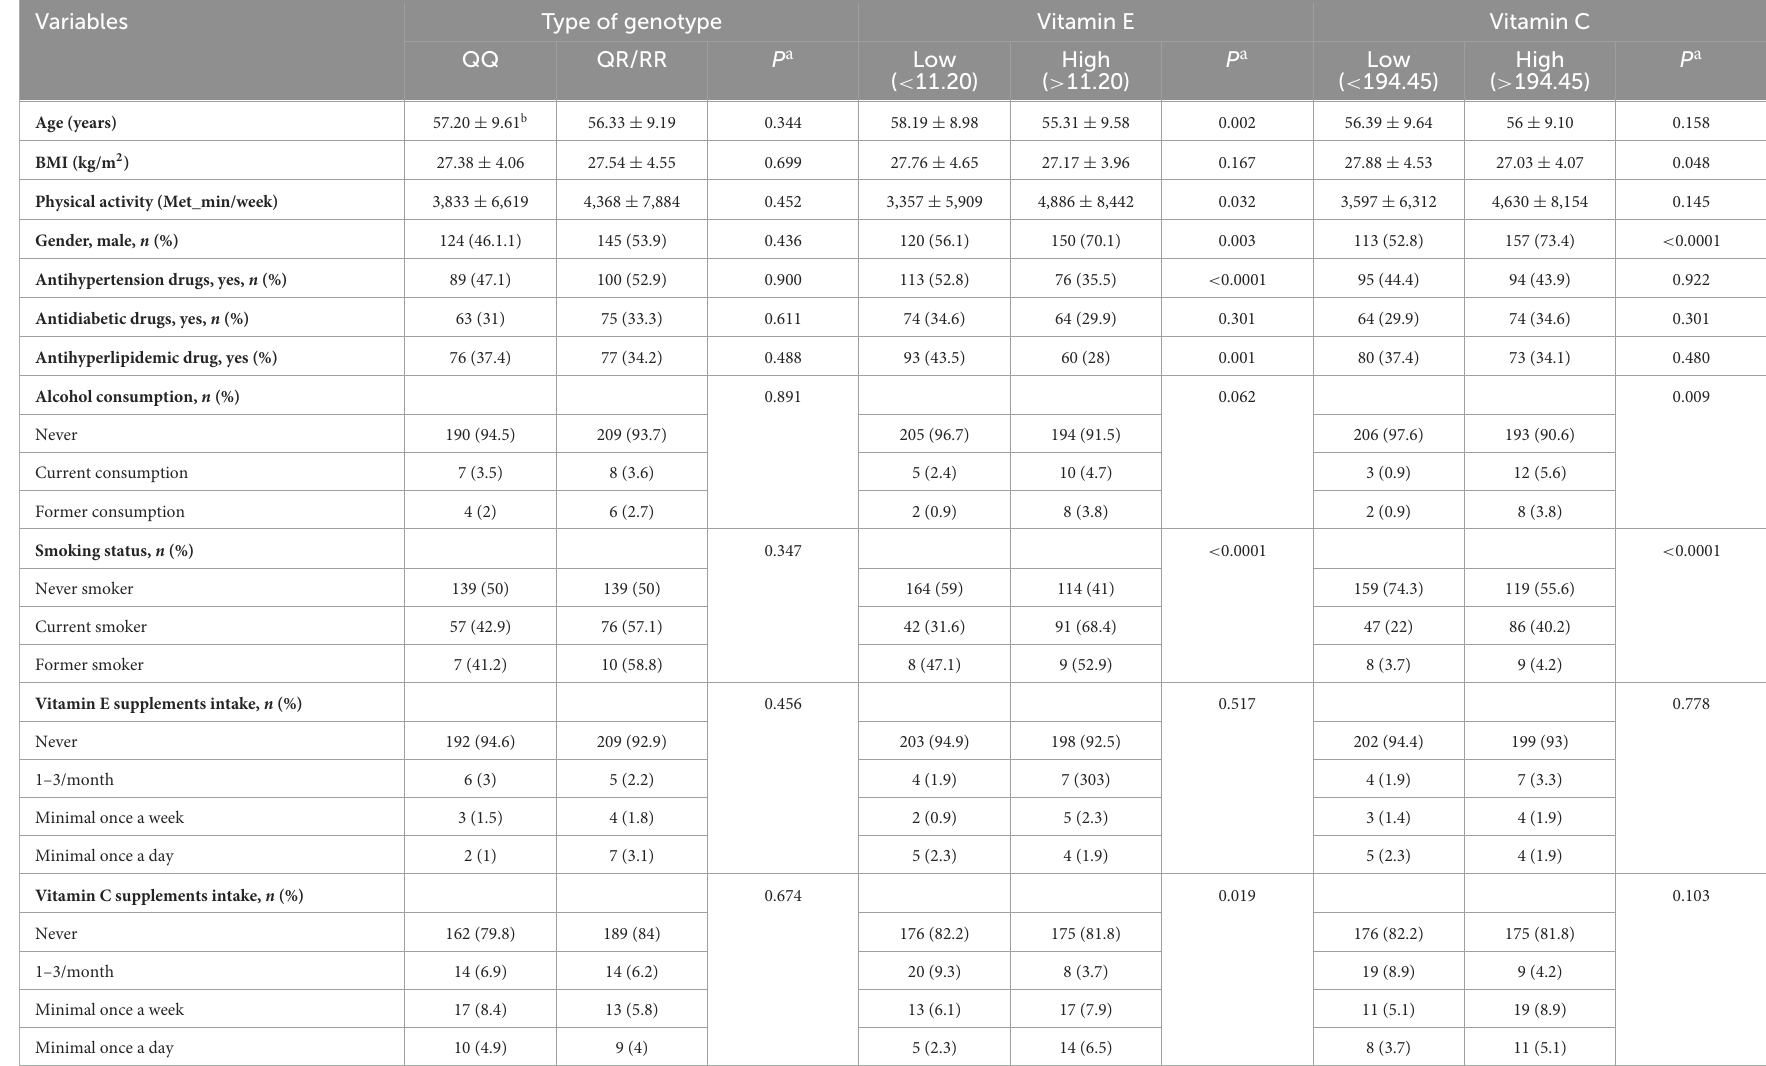
TABLE 1 Characteristics and dietary intake of study participants according to PON1 genotypes and two categories of vitamin E and C intake. Variables Type of genotype Vitamin E Vitamin